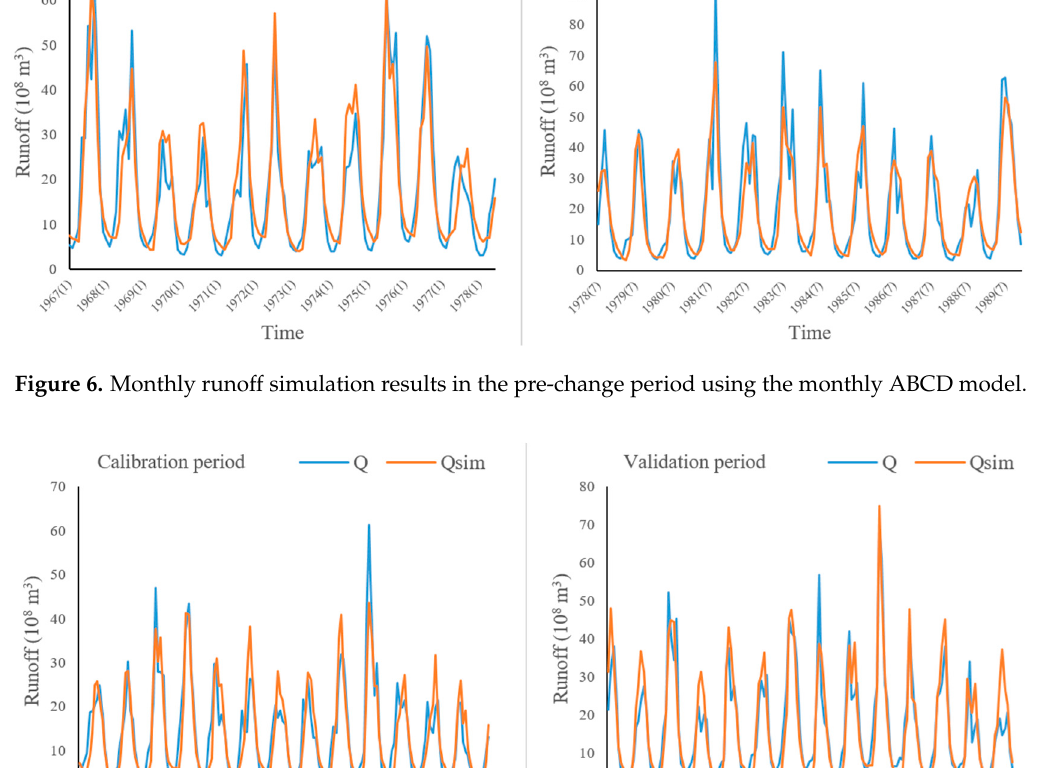
Figure 7. Monthly runoff simulation results in the post ‐ change period using the monthly ABCD model.